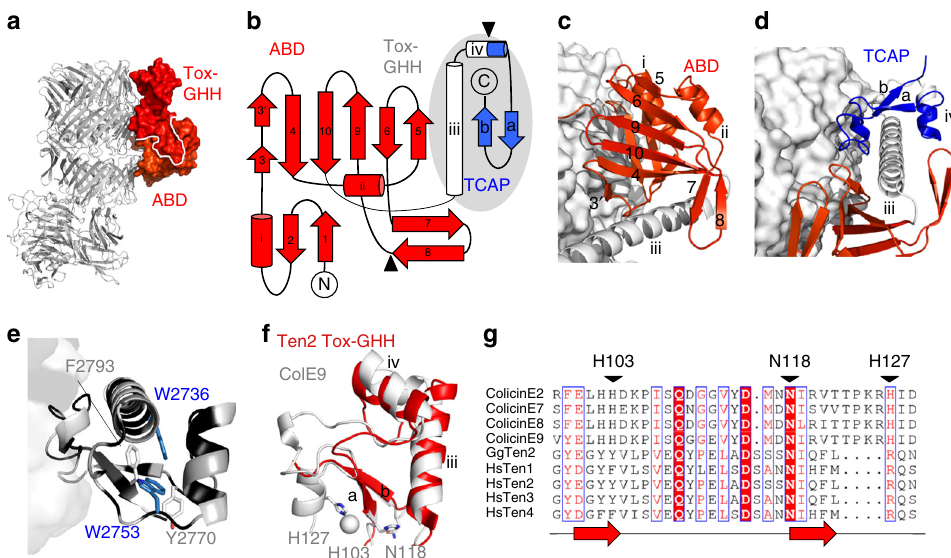
Fig. 5 The ABD and Tox-GHH domain. a The Ten2 ABD and Tox-GHH domain are shown in surface representation and coloured as in Fig. 1b. The rest of the protein is shown as grey ribbons, oriented as in Fig. 1b. b Schematic of the ABD and Tox-GHH folds. The Tox-GHH area is indicated by a grey oval. Within the Tox-GHH, the TCAP area is shown in blue. Reported protease cleavage sites are indicated by arrowheads. c The ABD is shown as red ribbons. The shell surface is coloured white. The Tox-GHH domain is shown as white ribbons. d View of the Tox-GHH domain, coloured white except for the TCAP region, which is coloured in blue. The shell is shown as white surface, the ABD is shown as red ribbons. e View of the Tox-GHH domain as ribbons and the shell as surface. Residues are coloured according to the sequence conservation score of each residue (black = conserved, white = not conserved). Selected hydrophobic residues, all of which are conserved in Teneurins, are labelled and side chains shown as sticks (white from the TCAP area, blue from upstream Tox-GHH areas). f Overlay of the Ten2 Tox-GHH domain (red ribbon) and the nuclease domain of Colicin E9 (white ribbon, PDB 1BXI). Side chains of catalytically important residues are shown as sticks, and the catalytically important ion in Colicin E9 shown as a grey sphere. g Structure-based sequence alignment of the Escherichia coli DNase colicins, all four human Teneurin paralogues and chicken Ten2. The alignment corresponds to the most C-terminal two β -strands of the Ten2 CT crystal structure. The catalytically important residues of the Colicins are indicated by arrowheads. Each arrow corresponds to one β